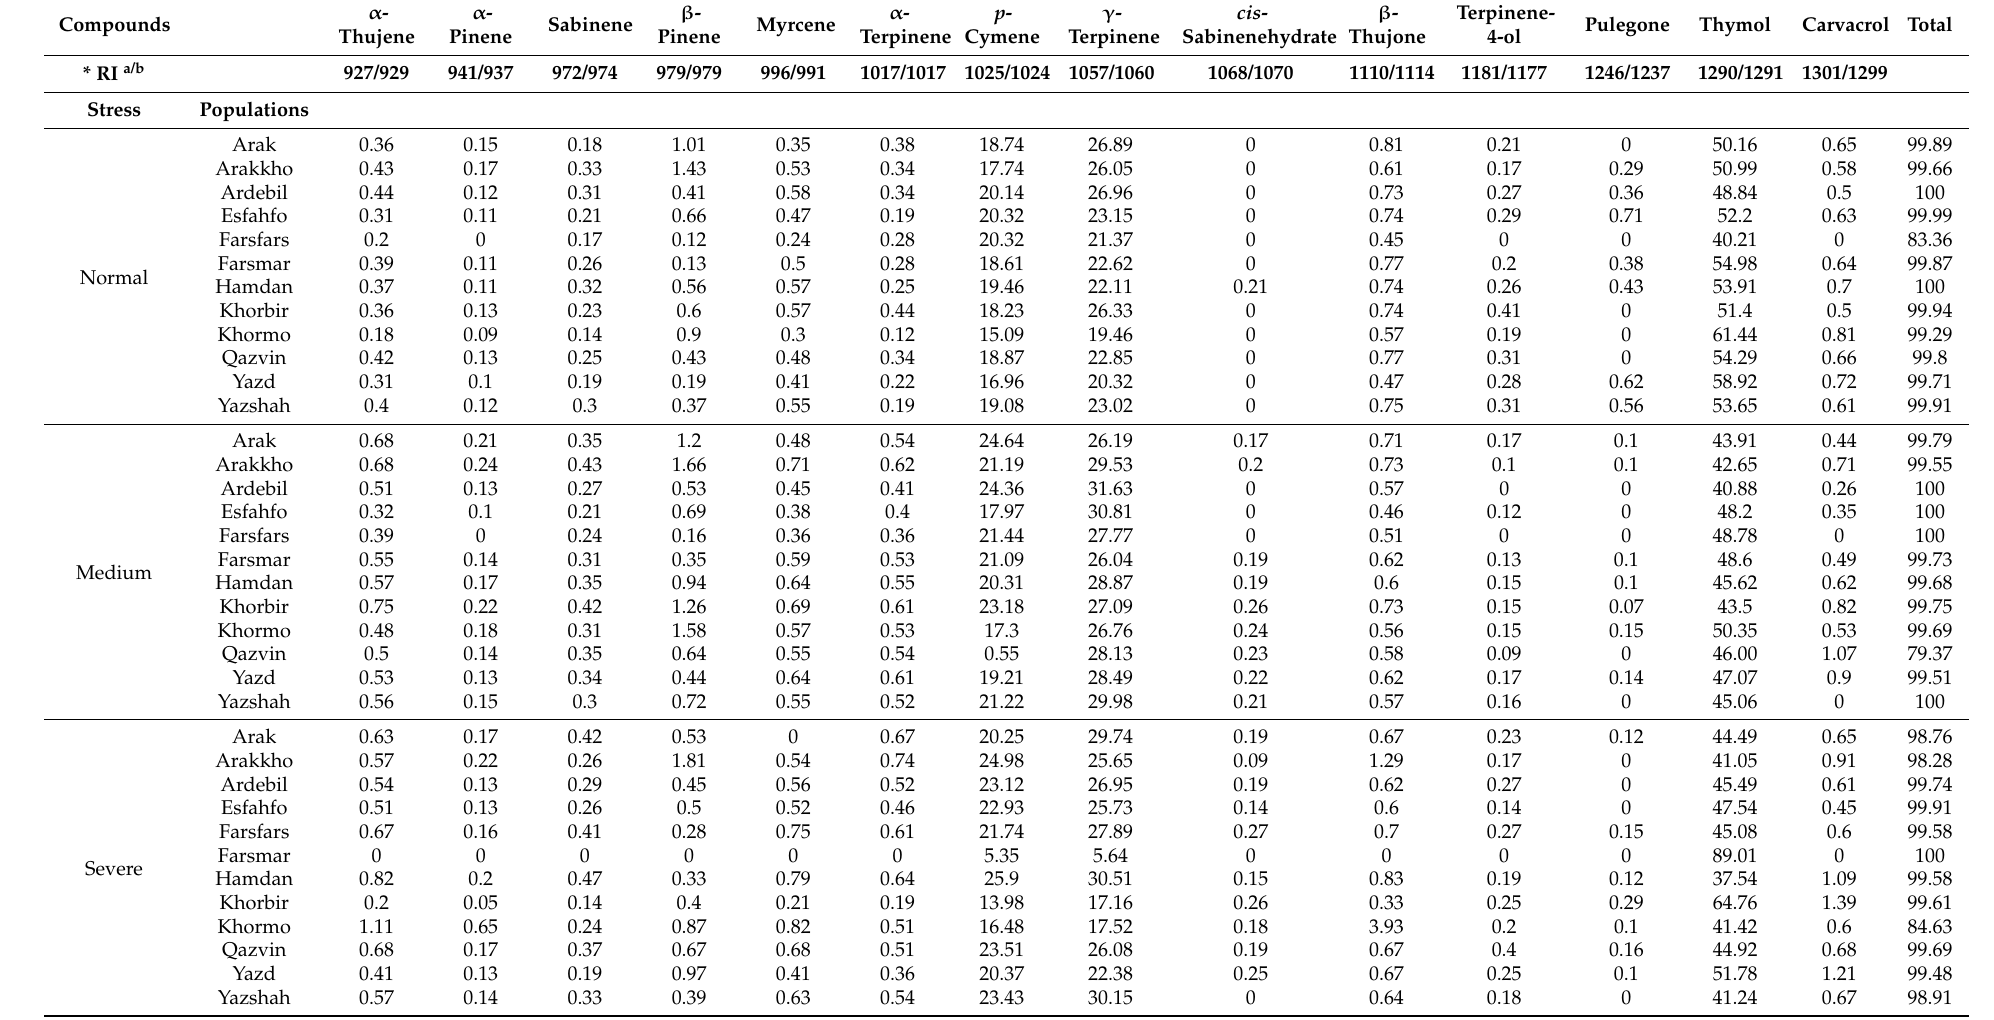
Table 2. Volatile compounds (relative quantity in %) of essential oils of studied ajowan